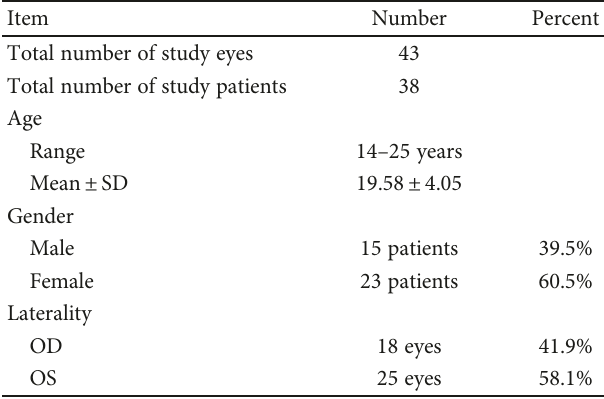
Table 1: Characteristics of the study